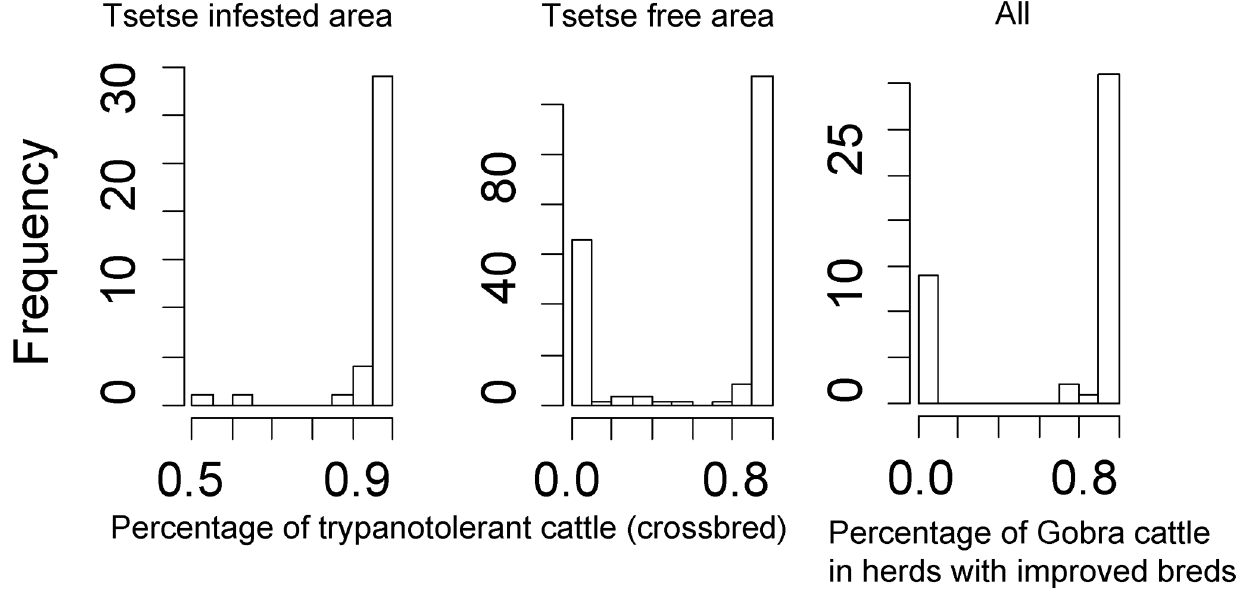
Figure 3. Frequencies of cattle breeds in relation to tsetse presence and farming system. The frequency of trypanotolerant cattle can be associated with two dominant groups, one based mainly on trypanotolerant cattle, and the second based on improved breeds, present almost only in the tsetse free area. The latter can be subdivided into two sub-groups based on the frequency of Gobra zebu cattle, which is the main breed for meat production in the area: an improved livestock keeping system targeting milk production, and a second one targeting meat production.